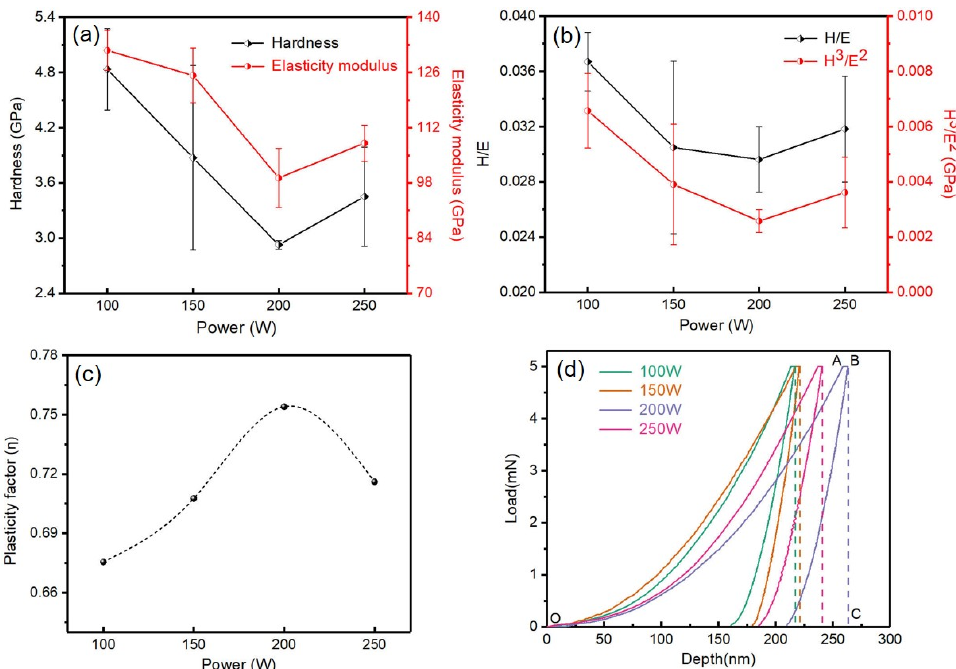
Figure 8. ( a ) Hardness and elasticity modulus, ( b ) H/E and H 3 /E 2 , ( c ) plasticity factor, and ( d ) load-depth curves of the Cr coatings under di ff erent powers.